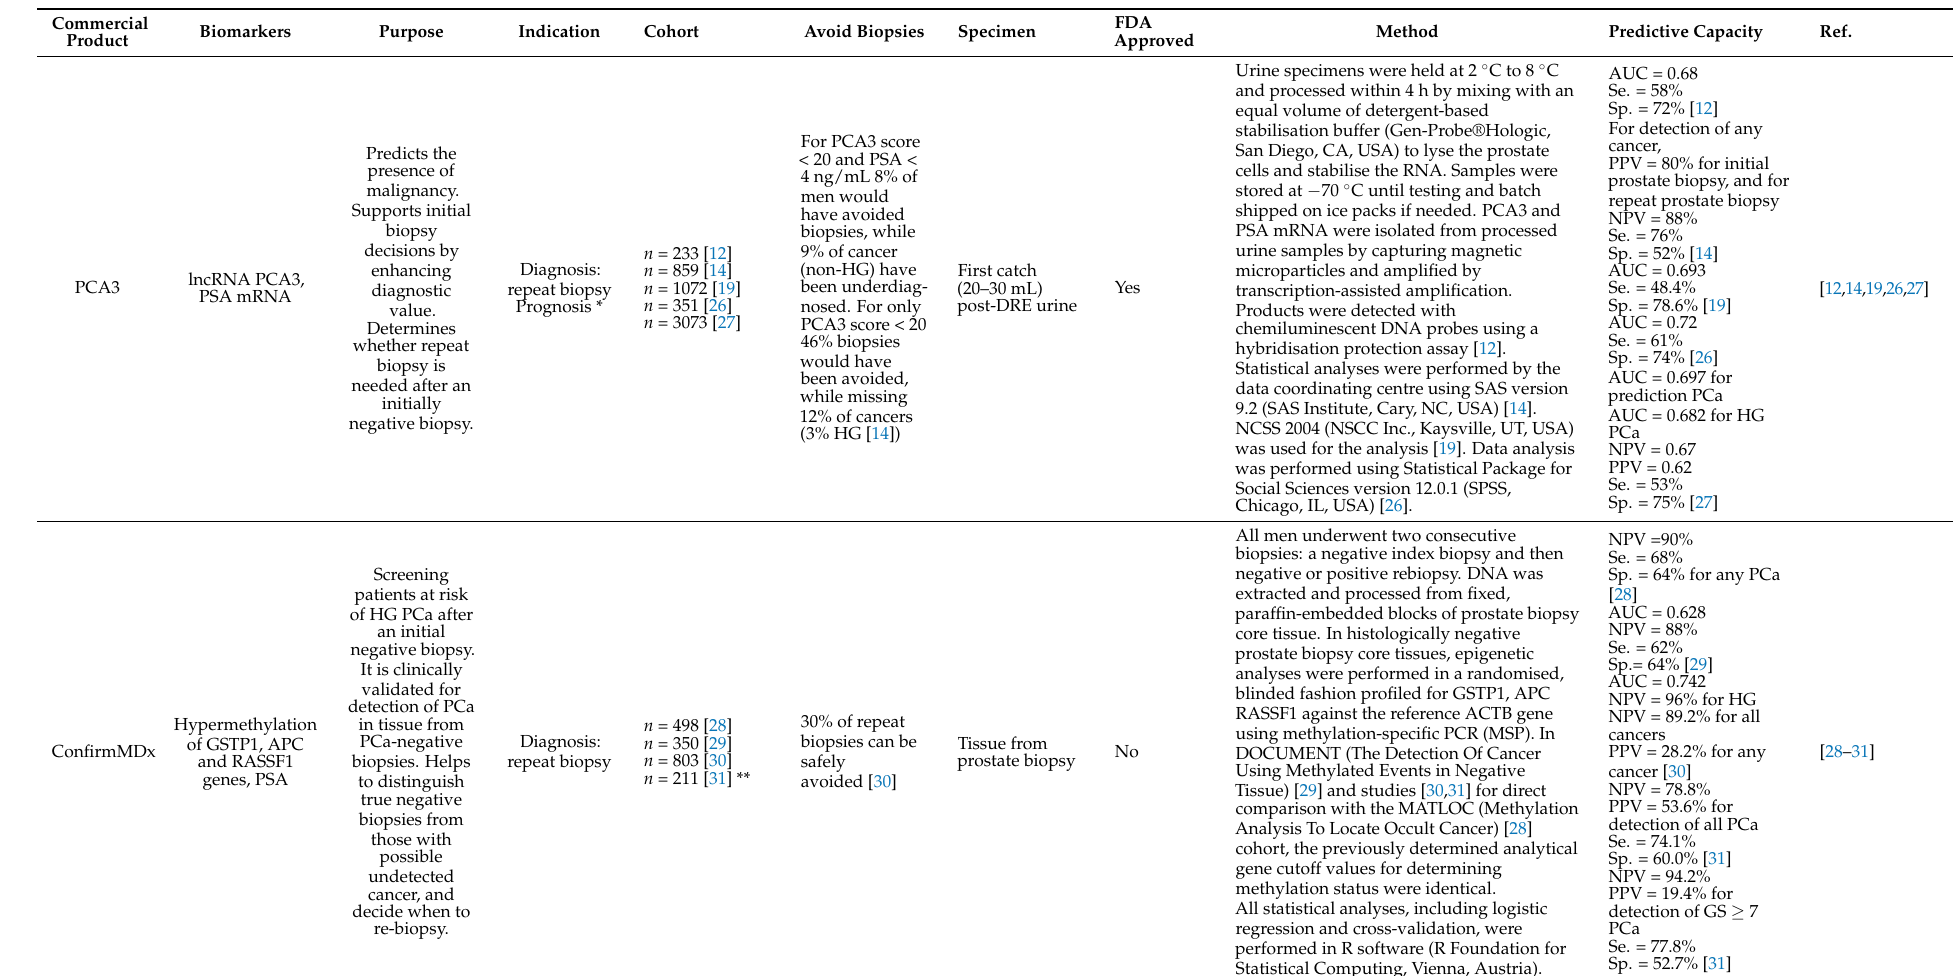
Table 1. Predictive capacity of prostate cancer after negative biopsy